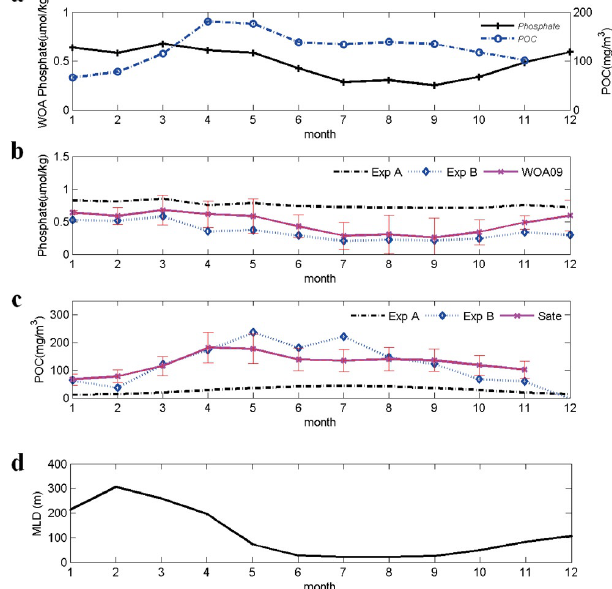
Fig. 6. Comparison of monthly phosphate and POC values in the central North Atlantic (position marked by green circle in Fig. 3). (a) WOA09 phosphate and satellite POC, (b) model-simulated phosphate for Exp A and Exp B together with WOA09 phosphate, (c) model-simulated POC for Exp A and Exp B together with satel- lite POC, and (d) monthly mixed layer depth (MLD, Monterey and Levitus,